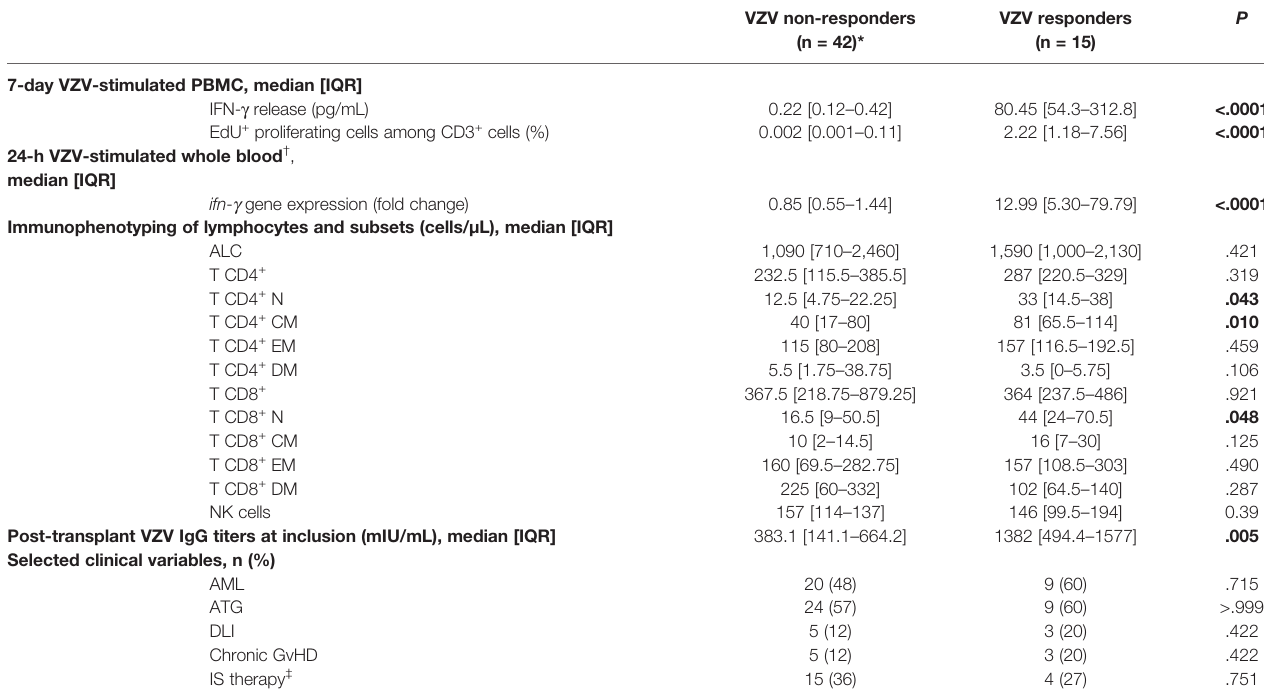
TABLE 2 | VZV-speci fi c immune responses of allogeneic hematopoietic stem cell transplantation recipients.